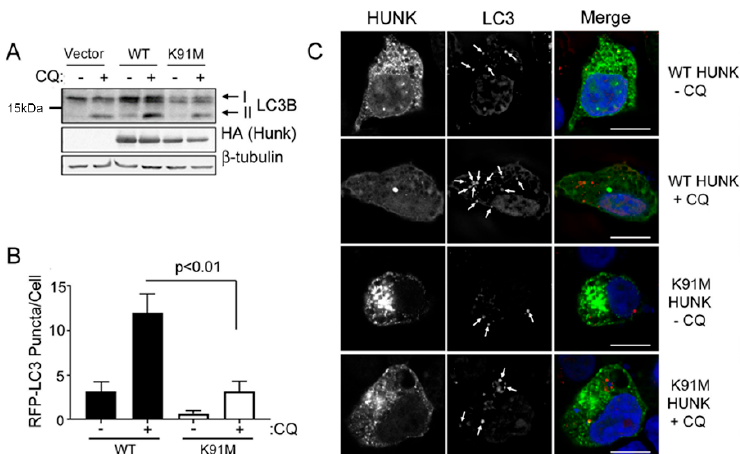
Figure 1. Hormonally Upregulated Neu-associated Kinase ( HUNK) activity is required for HUNK-mediated autophagy. ( A ) 293T cells were transfected with empty vector, HA-HUNK, or HA-K91M HUNK. Cells were then serum deprived and treated with 100 µM CQ for 4 h, lysed and analyzed for LC3B by immunoblot analysis. ( B ) 293T cells plated on coverslips were transfected with RFP-LC3B and either GFP-HUNK or GFP-K91M-HUNK. Cells were serum deprived and treated with 100 µM CQ for 4 h, followed by fixation and imaging. Quantitation of RFP-LC3B puncta in cells. N ≥ 3 fields per experiment. Data represent 3 or more experiments. Student’s T -test was used to perform statistical analysis. ( C ) Representative images of quantitation in ( B ). Scale bar size = 10 µm.